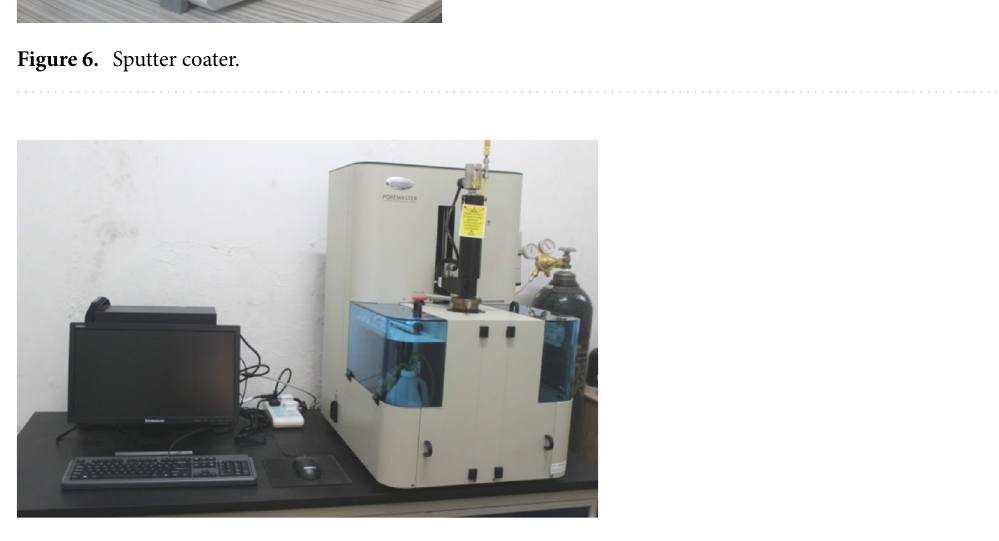
Figure 7. Automatic mercury